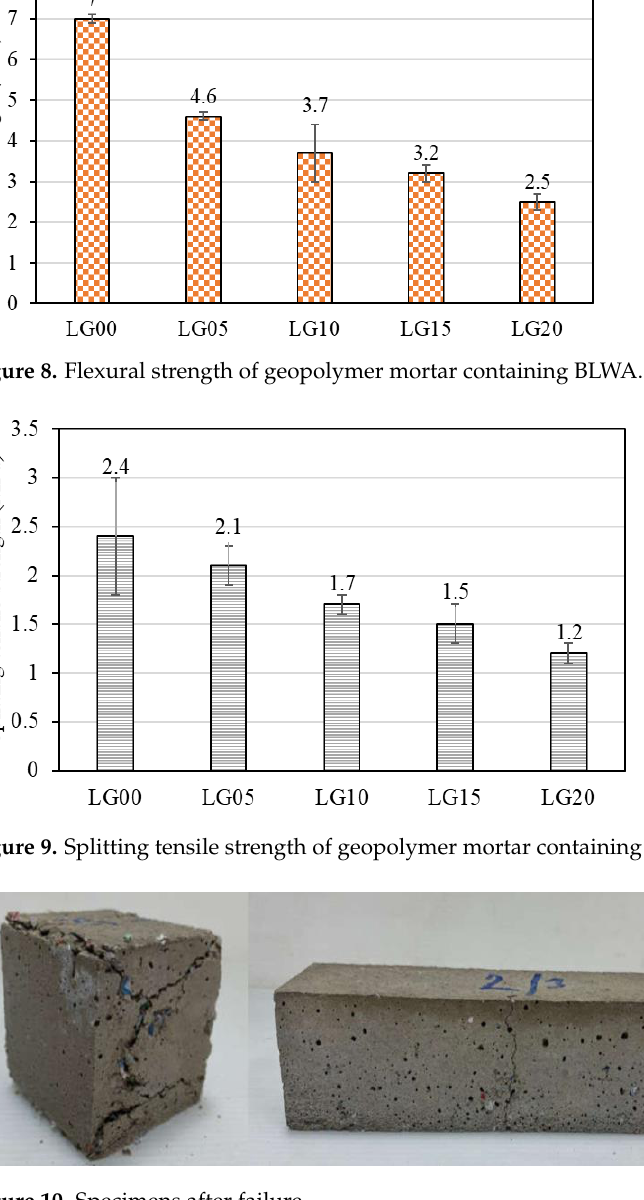
Figure 10. Specimens after